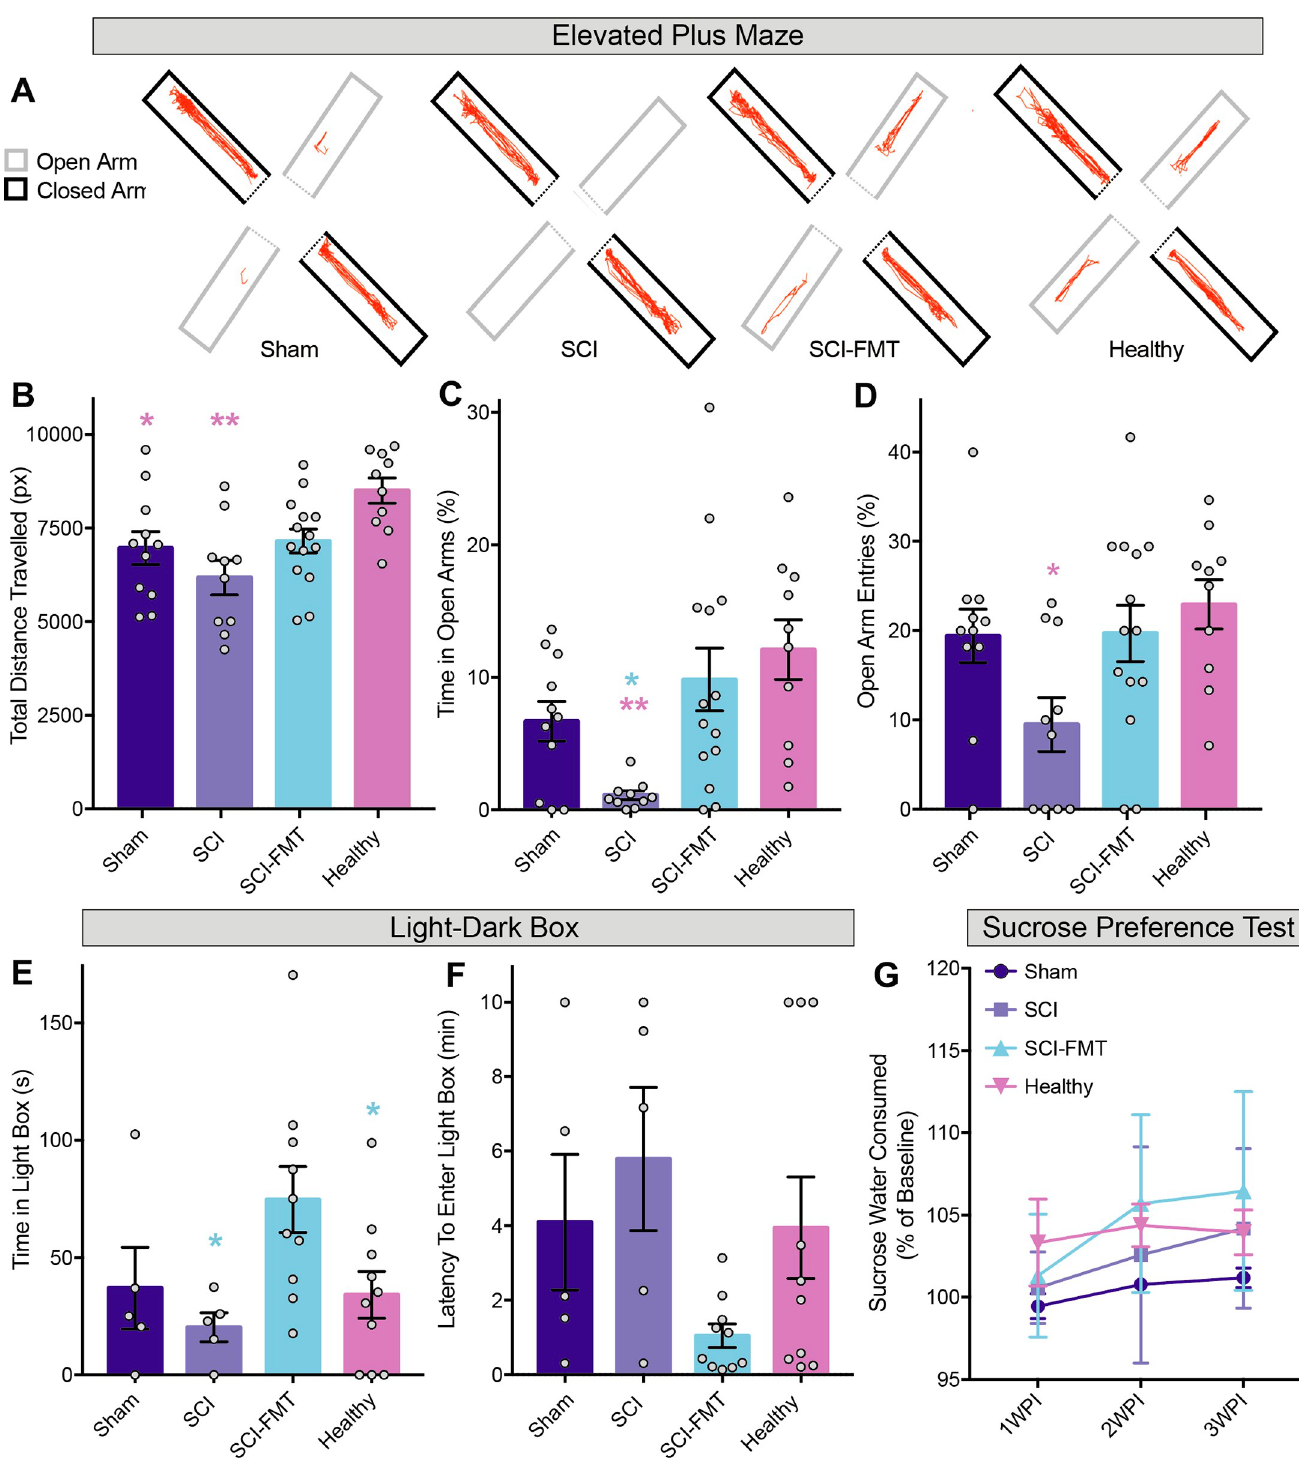
Fig 3. Treatment with a fecal microbiota transplant following spinal cord injury reduced anxiety-like behaviour. Animals were tested in the elevated plus maze 3 weeks following surgeries. (A) Representative images from the motion tracking software used to analyze the elevated plus maze. (B) Healthy animals travelled significantly further than the SCI group (one-way ANOVA; p = 0.0014) and sham group (p = 0.0469). Units of distance measured are expressed in pixels (Sham = 6964 px ± 1456, SCI = 6177 px ± 1456, SCI-FMT = 7146 px ± 1199, Healthy = 8500 px ± 1070). (C) Tukey’s multiple comparisons revealed that SCI rats spent significantly less time in the open arms compared to FMT treated and Healthy groups (one-way ANOVA; SCI vs. SCI-FMT p = 0.0119; SCI vs. Healthy